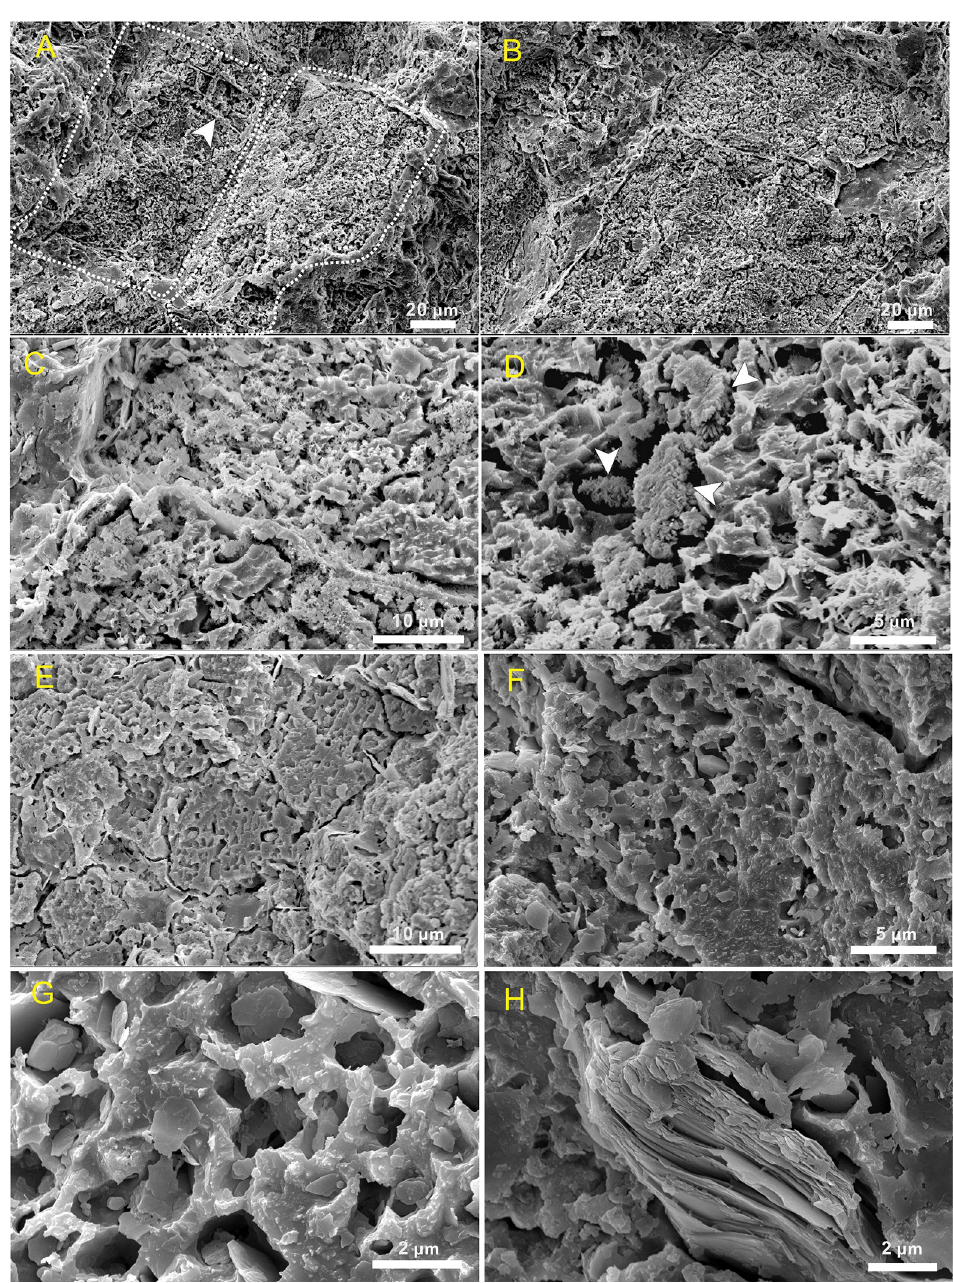
Fig 5. Scanning electron microscope images of rectangular and spherical capsules from Cambrian thrombolites. (A) Rectangular capsules (marked with dotted line) and smaller rectangles (marked with arrow). (B) Two rectangles connected end-to-end and sharing the same envelope. These capsules comprise micritic calcite in contrast to the surrounding sparry calcite. (C) Close-up view of envelopes that separate two capsules. (D) Some acicular or fibrous clay minerals in pits, marked with white arrows. (E) Irregular spherical capsules. (F) Close up of capsule showing pits arrayed equidistantly within calcite. (G) Hollow and round pits containing scattered lamellar minerals. (H) Lamellar envelopes around the